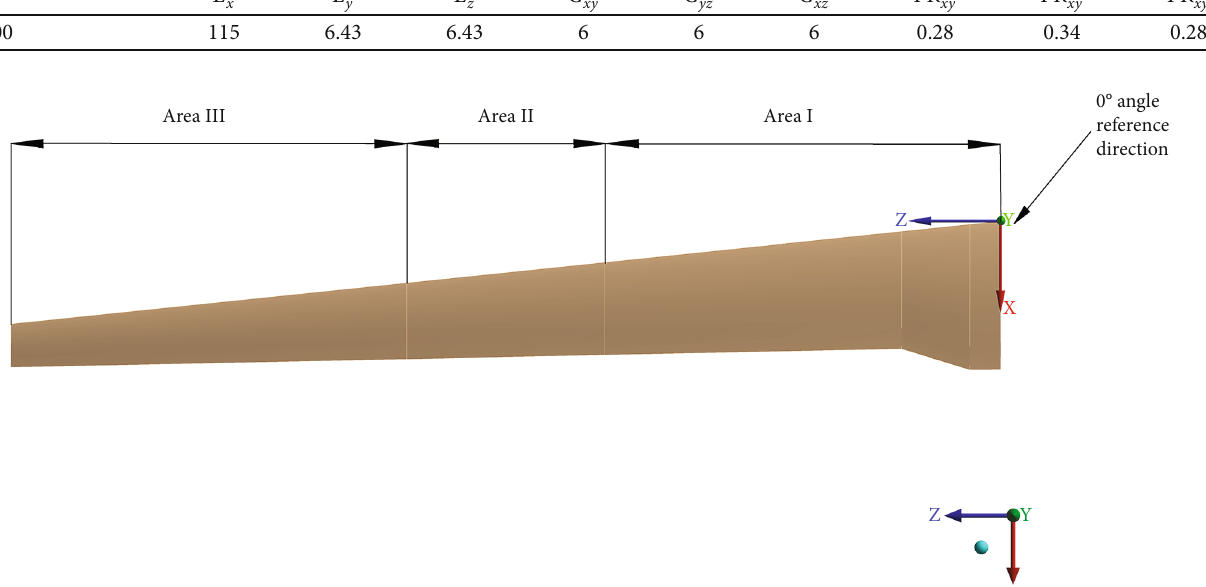
Figure 7: De fi nition of layup area and reference